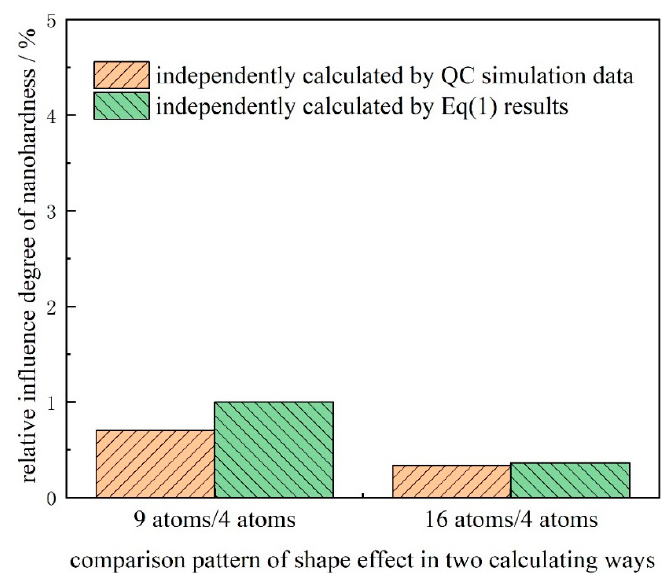
Figure 7. Relative influence on the nanohardness of triangular surface defects in two calculation